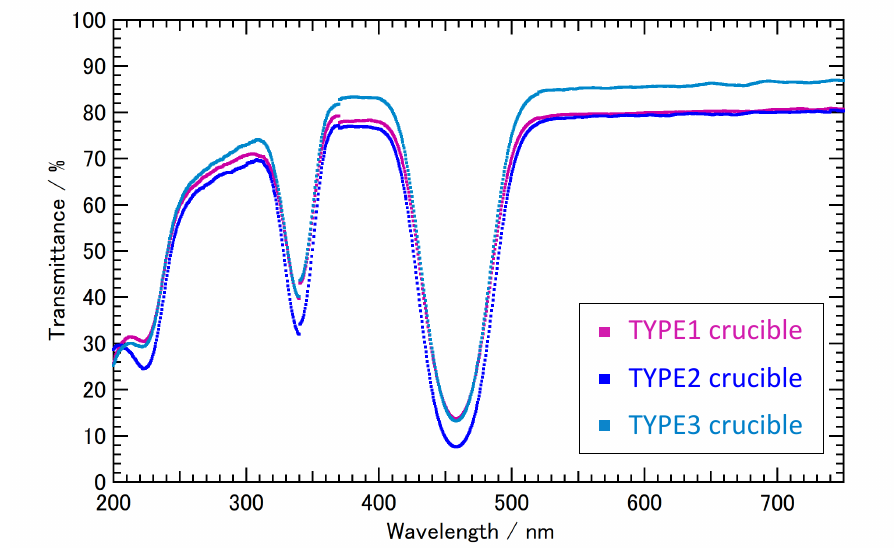
Figure 6. Optical transmittance spectra of grown crystals. In all samples, two distinct absorption bands were present at 340 nm and 455 nm, presumed to be absorption transitions at 4f rightarrow 5d 2 and 4f rightarrow 5d 1 , respectively. Transmission above 500 nm was above 70% in all